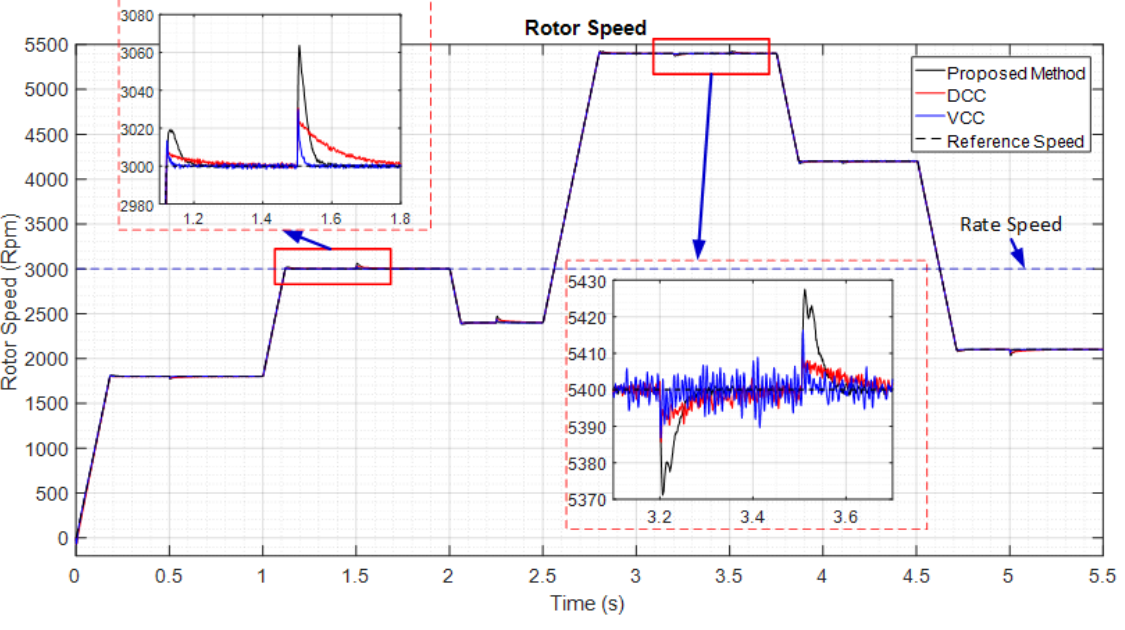
Figure 7. Comparative speed control results of PMSM.